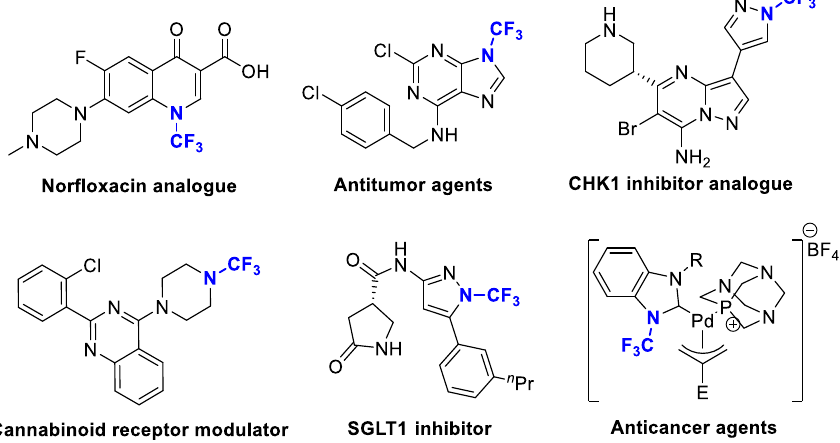
Figure 1. Drug analogues containing N -trifluoromethyl motif.